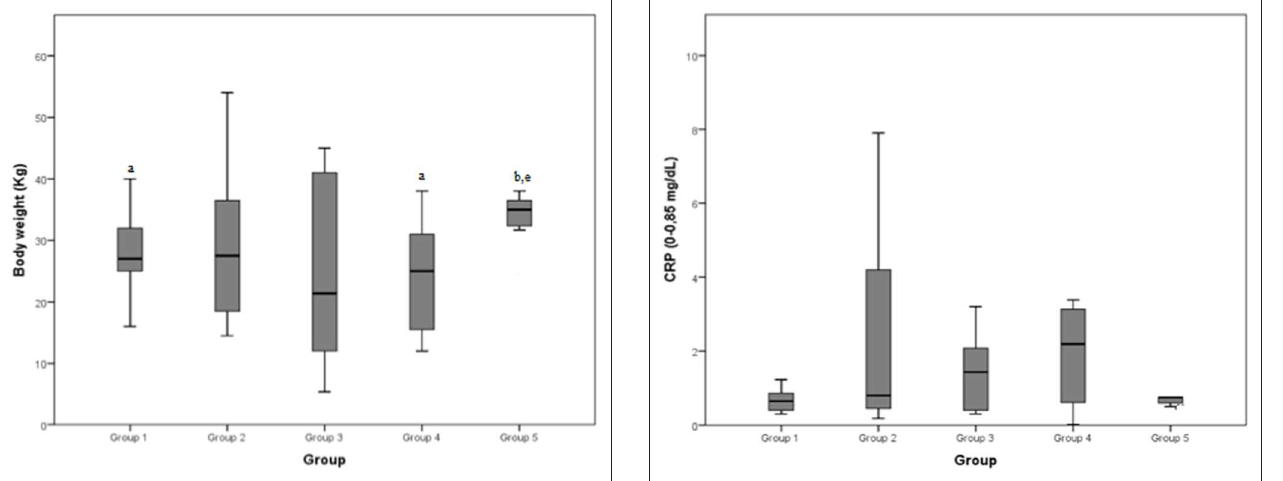
FIGURE 6 | Body weight (Kg) differences between the five examined groups. Statistically significant differences are indicated as follows: (a) significantly different from group 5; (b) significantly different from group 4; (e) significantly different from group 1.